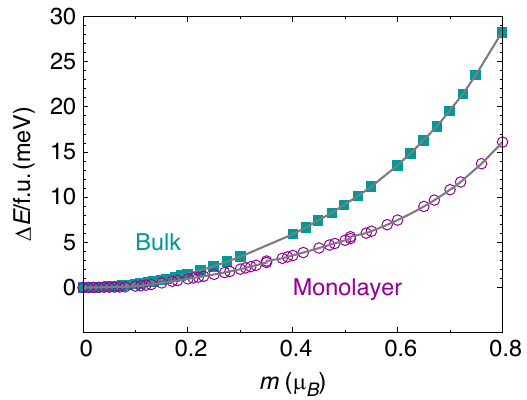
FIG. 3. Change in total energy per NbSe 2 formula unit (f.u.) of the bulk (square) and monolayer (circle) structures with respect to the nonmagnetic state as a function of magnetic moment obtained from collinear fixed-spin moment calculations. The gray solid lines are a fit to Eq. (2).